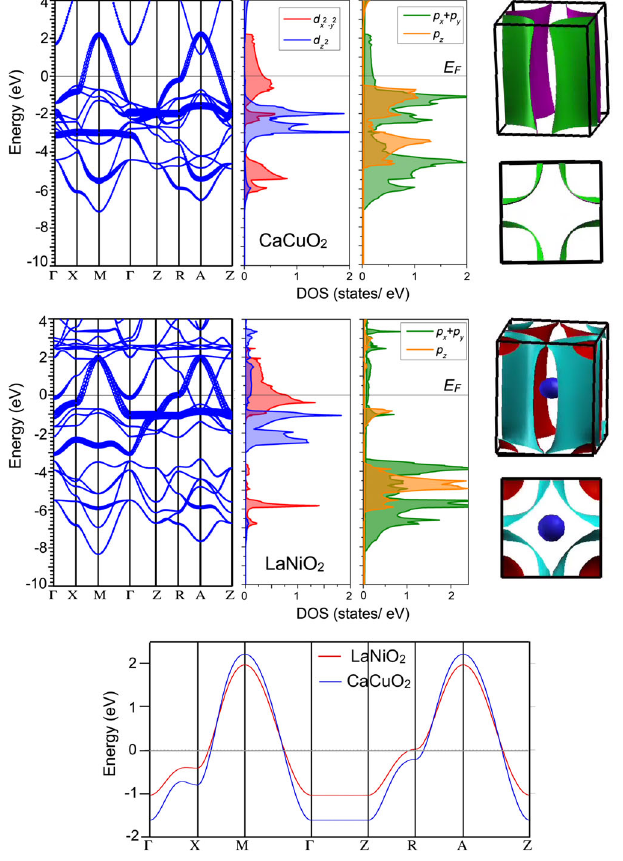
FIG. 2. Top and middle panels. Comparison of the Fermi surface, band structure ( d and d characters highlighted), x 2 − y 2 z 2 and orbital-resolved density of states (Ni = Cu d and d , x 2 − y 2 z 2 FIG. 3. Wannier fits (red) and density-functional theory band O p , p , and p ) of CaCuO 2 and LaNiO 2 . Bottom panel. Tight x y z structures (blue) of CaCuO 2 (top) and LaNiO 2 (middle). Com- band at the Fermi energy for both binding fit to the d x 2 − y 2 parison of Wannier functions of the d materials. CaCuO 2 and LaNiO 2 (bottom); the rest are shown in Fig. 2 of Ref. [25]. Colors represent the sign of the Wannier function. The large spheres are the Ca (cyan) and La (gray)